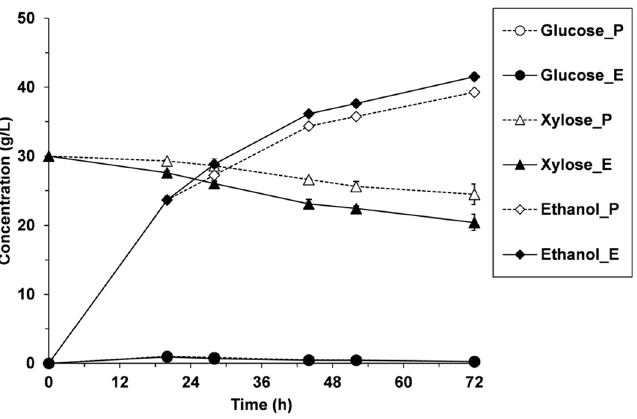
Figure 3. SSF of steam-exploded wheat straw (WIS supplemented with xylose), using the parental (P) and evolved (E) S. cerevisiae